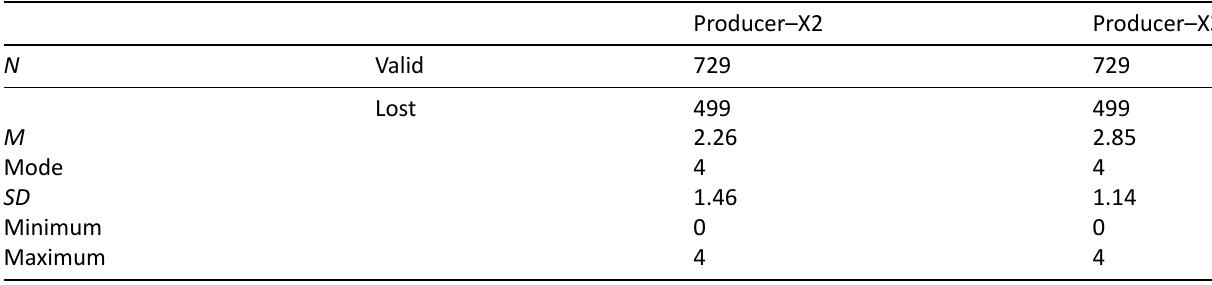
Figure 1. Error bars (item X1 and type of educational institution). Table 2. Descriptive statistics